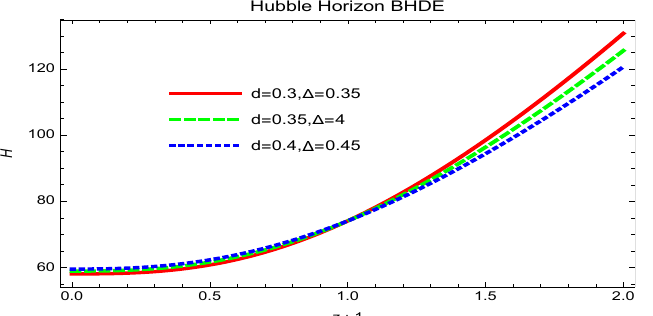
Figure 1. Estimation of Hubble parameter H versus redshift parameter 1 + z for interaction BHDE model with Hubble horizon in case of GDP braneworld cosmology.